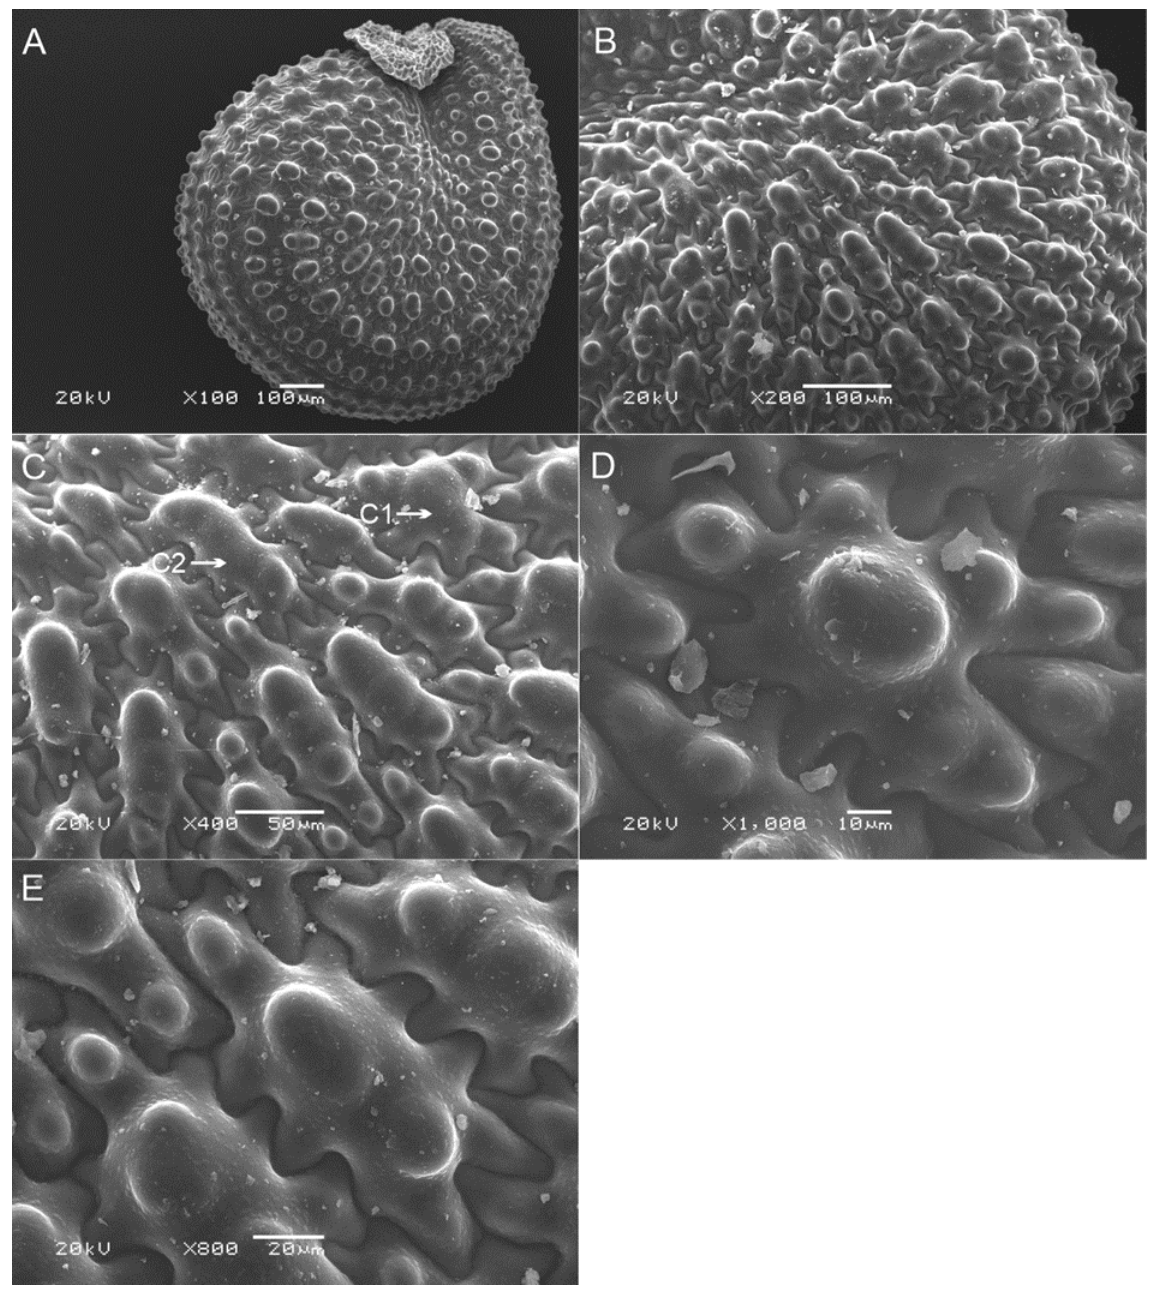
Figure 8 Portulaca trituberculata (SEM). General view of the seed ( A ). e seed surface ( B,C ). Isodiametric cell ( C1 ), elongated cell ( C2 ); general view of the cells ( D,E